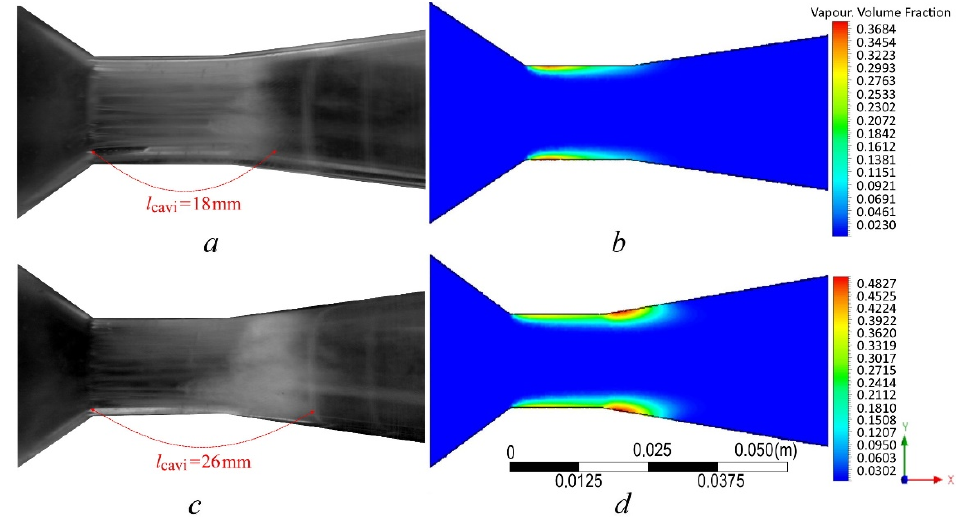
Figure 5. Numerical and experimental results. Venturi tube. ( a , b )—inlet pressure 1.3 atm, ( c , d )—inlet pressure 1.5 atm.